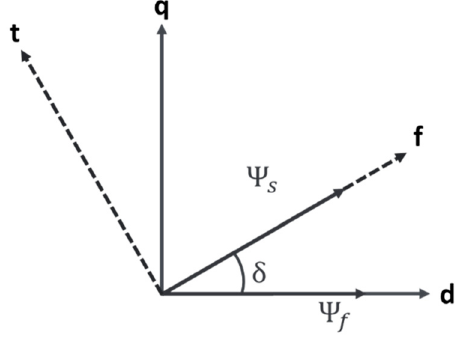
Figure 1. The f - t frame and d - q frame [12,13].